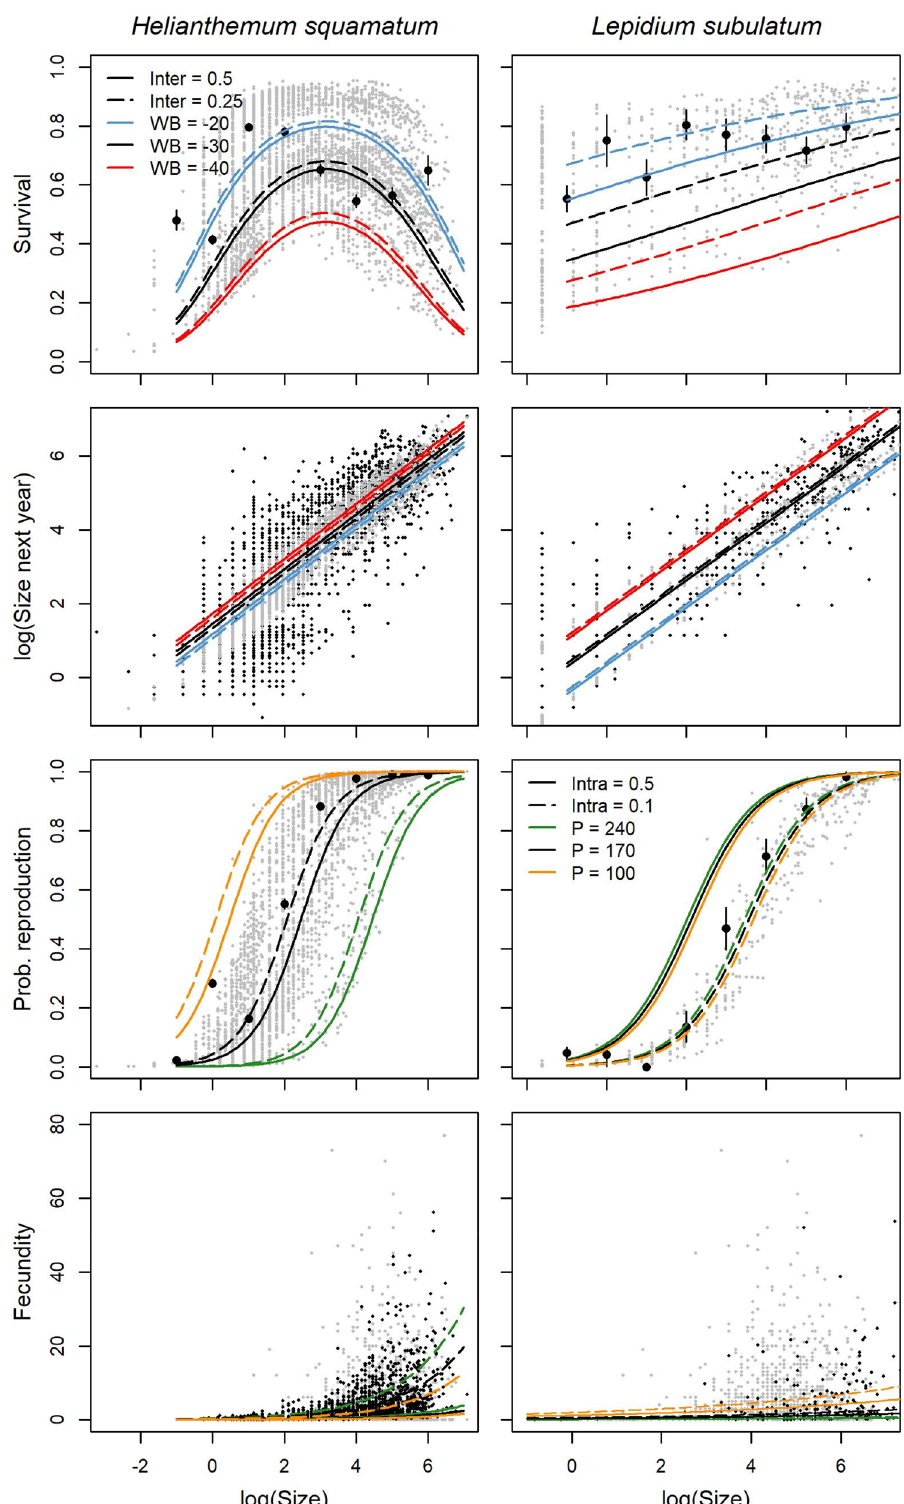
Figure 1. Relationships between plant size and vital rates (survival, growth, probability of reproduction, fecundity) in H. squamatum and L. subulatum modelled with GLMMs. Black dots are observed values, mean values with standard errors in the cases or survival and probability of reproduction. Grey dots represent predicted values. Lines represent variations in adjusted values related to variations in two of the explanatory variables included in the most explanatory model selected by species and vital rate. Intra intraspecific interaction index, Inter interspecific interactions index, WB summer water balance, P spring